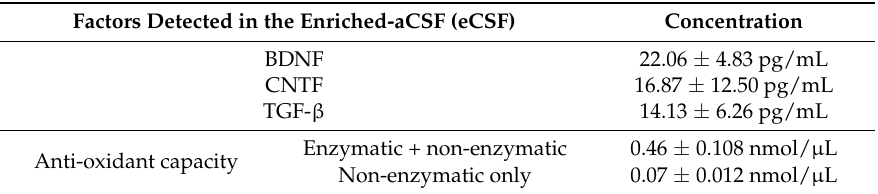
Table 1. Factors secreted by MSCs growing in